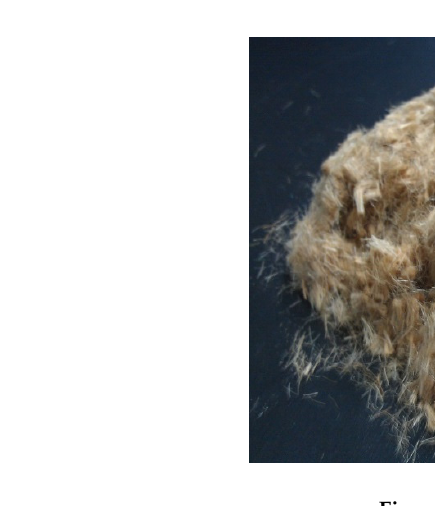
Figure 1. Photo of jute fiber. Table 4. Properties of natural jute fiber.